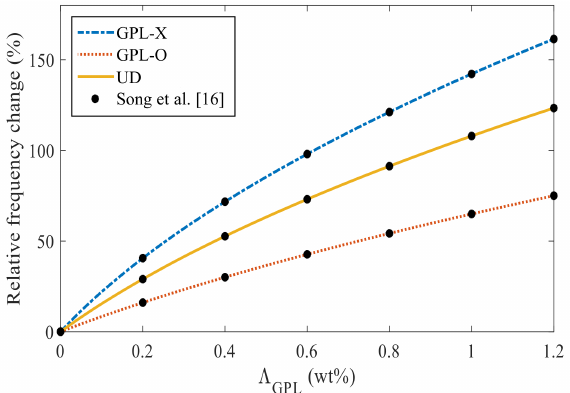
Figure 7. Relative frequency variation vs. the GPL weight fraction, for different GPL distribution patterns ( b / a = 1, a / h = 10, and SSSS boundary condition).